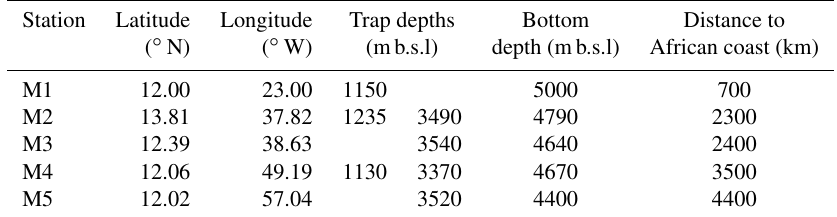
Table 1. Locations and depths of the sampling stations M1–M5. BSL: below sea level. Station Latitude Longitude Trap depths Bottom Distance to ( ◦ N) ( ◦ W) (mb.s.l) depth (mb.s.l) African coast (km) M1 12.00 23.00 1150 5000 700